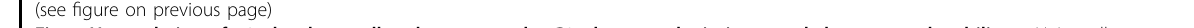
Fig. 7 Upregulation of p21 levels or cell-cycle arrest at the G2 phase results in improved chromosomal stability. a HeLa cells were transfected with sip21, and after 30 h cells were treated with nocodazole for 16 h. After nocodazole release, cells were subjected to western blotting (top panel) with p21 and GAPDH (loading control) antibodies. Mitotic cells were analyzed by ICC, and the number of micronucleated cells was calculated (bottom panel); representative fl uorescent images show micronuclei (white arrowhead denotes micronuclei). The results are given as the mean ± SD from three independent experiments ( n = 300). *** P < 0.001 as assessed by Student ’ s t -test. b Same as in a . Mitotic cells (as indicated above) were collected and stained with aceto-orcein to visualize cells with condensed chromosomes. The percentage of mitotic cells with condensed chromosomes was calculated at the indicated time points. The results are given as the mean ± SD from three independent experiments ( n = 300). c Co-transfection of sicGAS with or without a p21 plasmid was performed for 30 h. Then, cells were treated with nocodazole for 16 h before being analyzed by western blot (top panel) with the indicated antibodies as well as by ICC (bottom panel) for enumeration of micronucleated cells; representative fl uorescent images show micronuclei (white arrowhead denotes micronuclei). The results are given as the mean ± SD from three independent experiments ( n = 300). *** P < 0.001 as assessed by Student ’ s t -test. d cGAS − / − HeLa cells were transfected with p21 plasmid, and after 12 h they were treated with nocodazole for 16 h. After 16 h, cells were subjected to western blotting (top panel) with the indicated antibodies, and mitotic cells that were collected upon cessation of nocodazole treatment were reseeded on a coverslip so that ICC could be performed. Immunocytochemical analysis (bottom panel) was used to detect and count the percentage of cells showing micronuclei; representative fl uorescent images show micronuclei (white arrowhead denotes micronuclei). The results are given as the mean ± SD from three independent experiments ( n = 300). *** P < 0.001 as assessed by Student ’ s t -test. e HeLa cells transfected with sicGAS and synchronized by double thymidine block for 40 h were released from arrest and then 7 h later were treated with RO3306 for 3 h. Mitotic cells with or without RO3306 treatment were collected by shaking the plate at 9 and 10 h, and then they were reseeded on a coverslip to assess chromosomal instability phenotypes, i.e., micronuclei by immunocytochemistry (bottom panel); representative fl uorescent images show micronuclei (white arrowhead denotes micronuclei). Western blotting was performed with the indicated antibodies to con fi rm cGAS downregulation (top panel). f Same as indicated in e . Six hours after release from DTB, quanti fi cation of the percentage of mitotic cells with condensed chromosomes was performed by aceto-orcein staining at the indicated time points; the cells analyzed were those with or without RO3306 treatment for 3 h, which occurred 7 h after release from DTB. The results are given as the mean ± SD from three independent experiments ( n = 300). g Cells were cotransfected with sicGAS and pcDNA (control vector) or p21 and then were subjected to DTB. After release from DTB, cells were harvested at the indicated time points and stained with aceto-orcein to count mitotic cells with condensed chromosomes. The results are given as the mean ± SD from three independent experiments ( n =